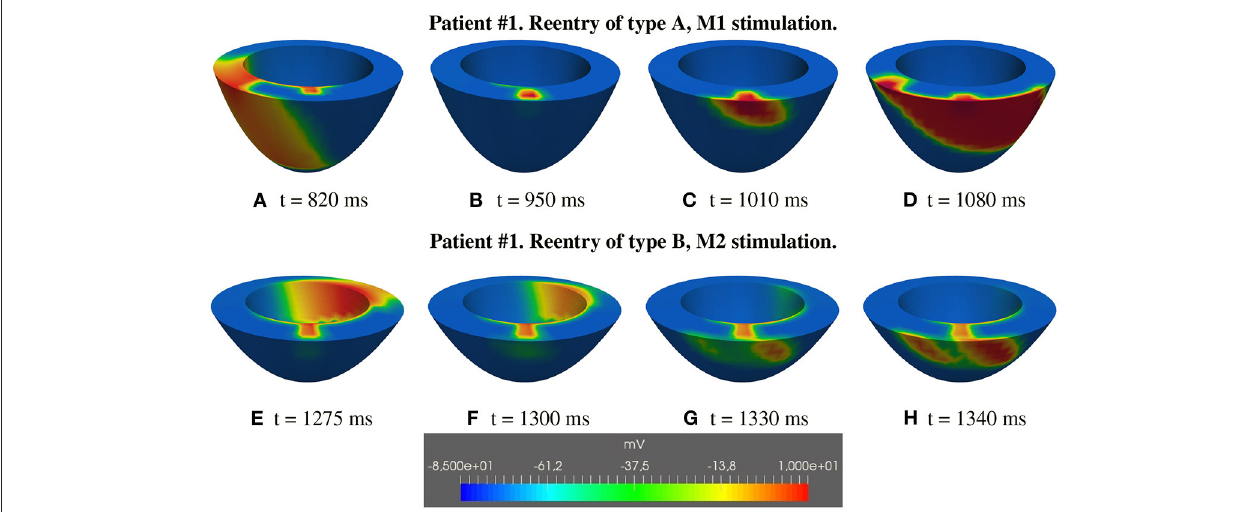
FIGURE 14 | Patient #1. Reentry of types A and B. (A–H) Transmembrane potential snapshots on transmural sections across the central isthmus (First row) and across the apical isthmus (Second row). t = 0 corresponds to the S1 stimulus. The S2 stimulus is applied at t = 350 ms. First row : Reentry of type A related to M1 stimulation. Second row : Reentry of type B related to M2